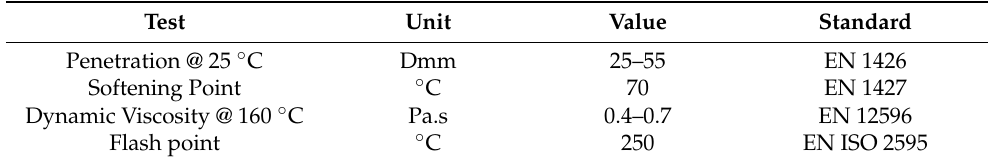
Table 1. Rheological properties of the bitumen. Test Unit Value